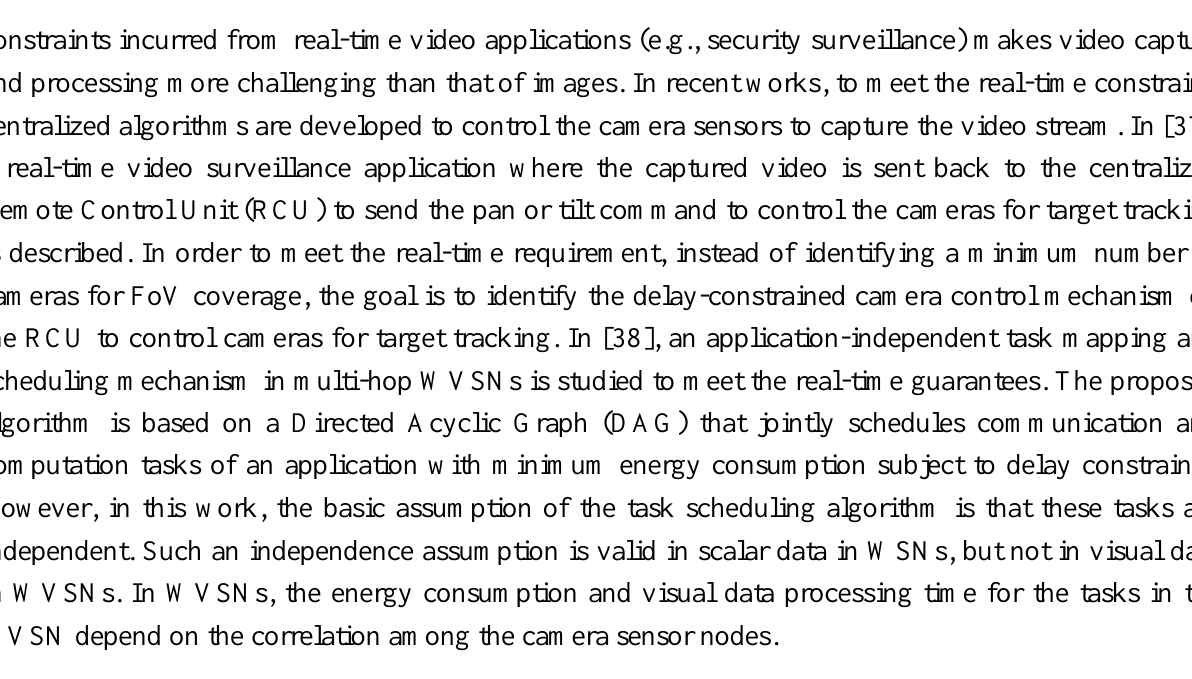
Table 3. Research works on visual data capture in